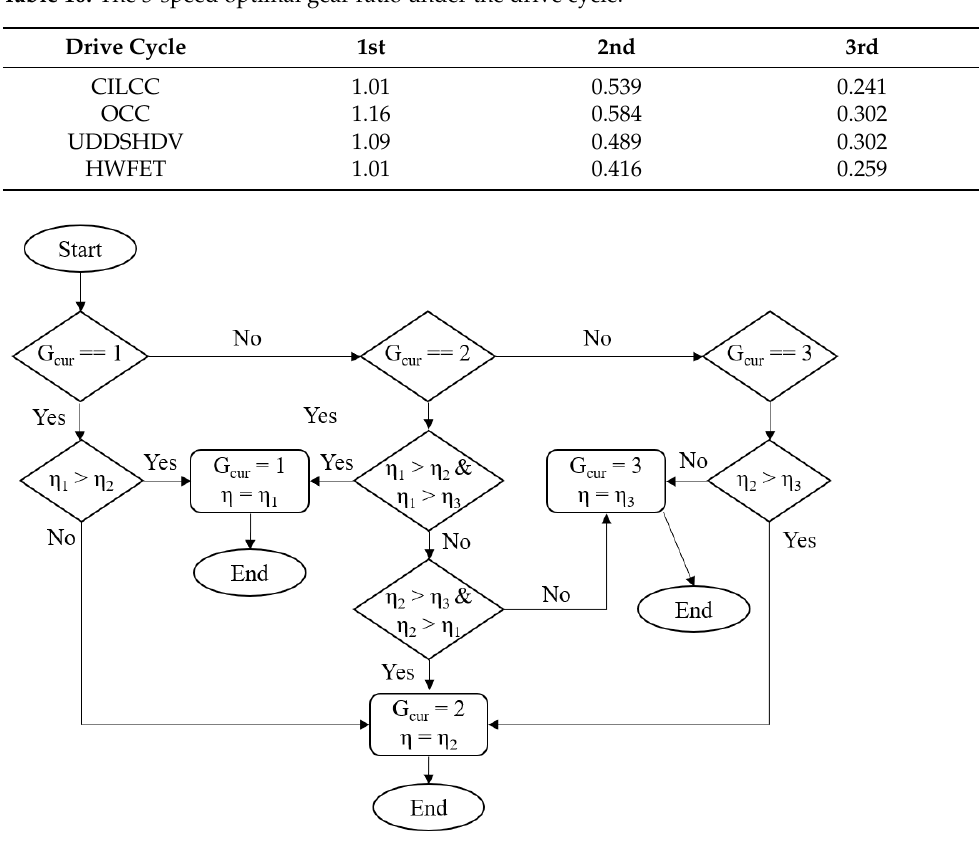
Figure 22. Flowchart for the 3-speed gear shifting strategy.